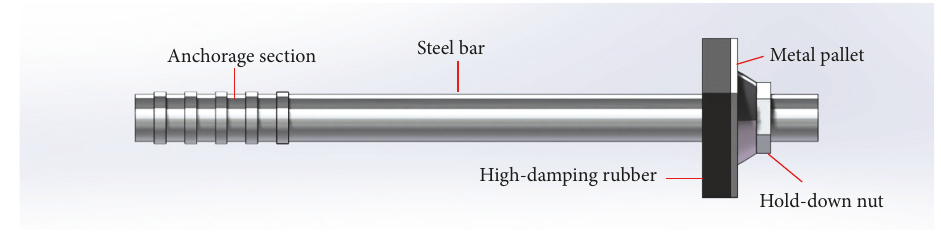
Figure 1: Schematic diagram of energy-absorbing